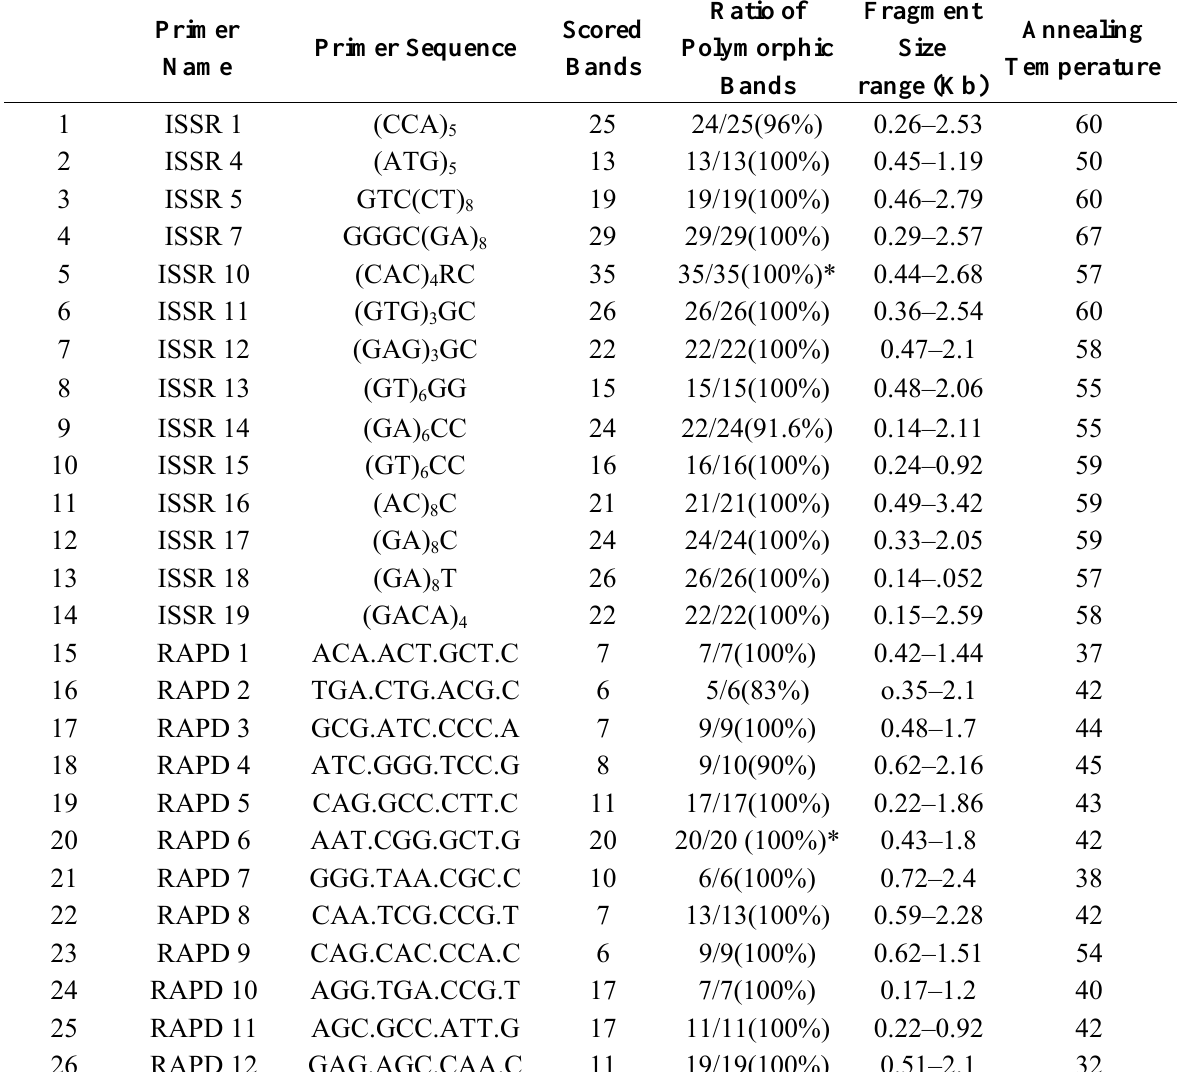
Table 2. Summary of characteristics of primers and ratio of polymorphic ISSR and RAPD loci and Fragment size range (Kb) in